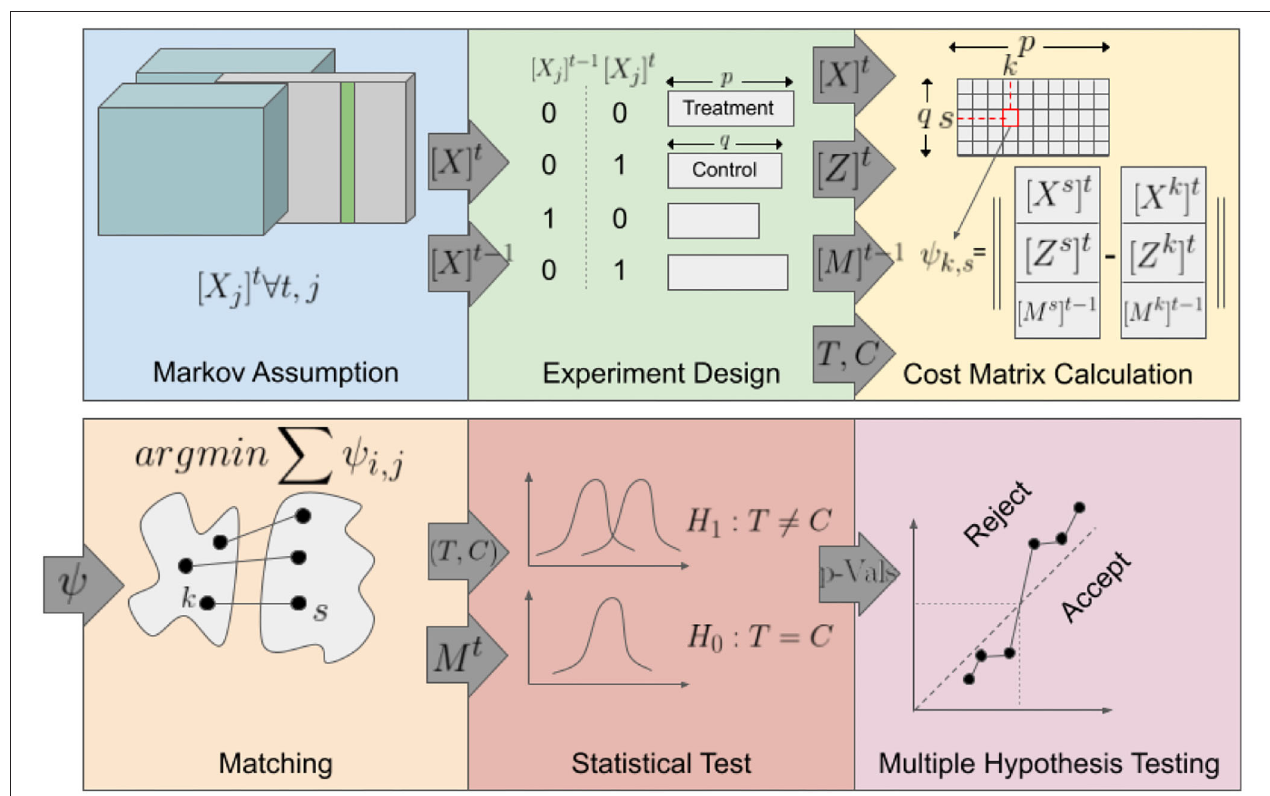
FIGURE 2 | Overview of the method; schematic overview of the steps involved in the QED.